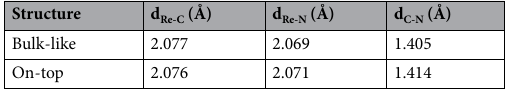
Table 2. Calculated average distances in the ReCN bilayers.